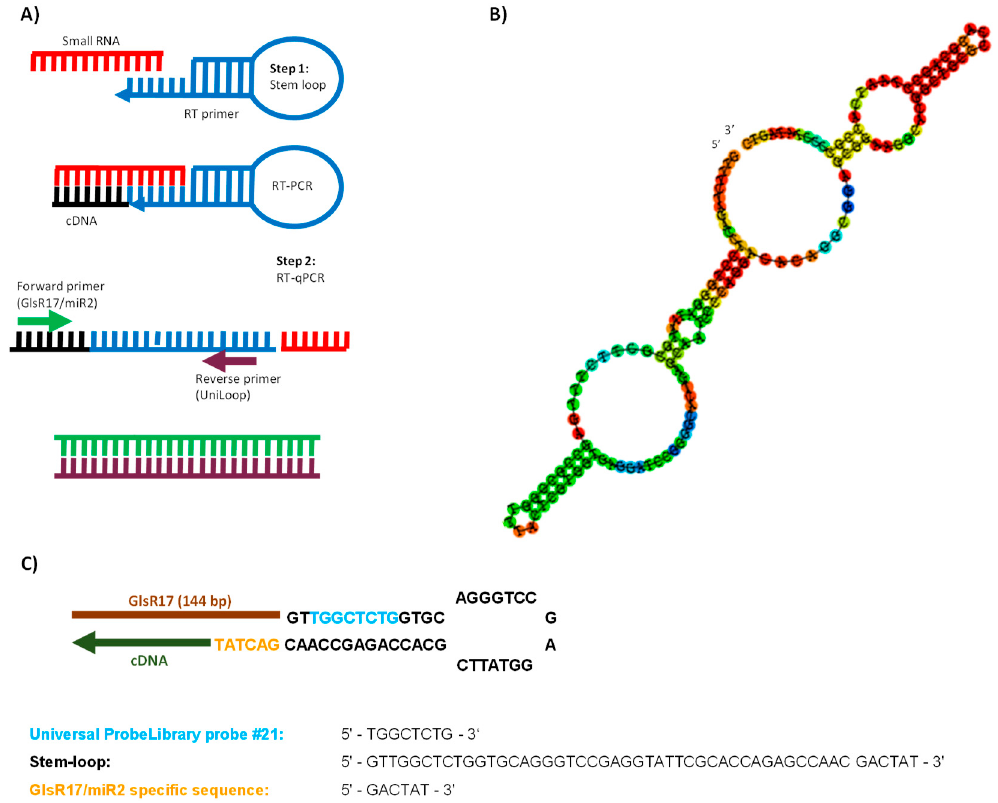
Figure 1. Stem-loop quantitative reverse transcription PCR (RT-qPCR) design to identify small RNAs of Giardia lamblia and schematic representation of the GlsR17 folding. ( A ) The scheme indicates the formation of complementary DNA (cDNA) from stem-loop-small RNA (step 1) and the quantification of the expression by RT-qPCR (step 2); ( B ) predicted structure of the small nucleolar RNA (snoRNA) GlsR17 based on RNAFold; ( C ) structure of the Stem-loop-GlsR17 probe hybridizing to the target small RNA; the cDNA generated by reverse transcription is shown in green color, the Universal ProbeLibrary (UPL) 21 region in blue, and the sequence specific for capturing the GlsR17 and miR2 RNAs (GACTAT) in yellow.